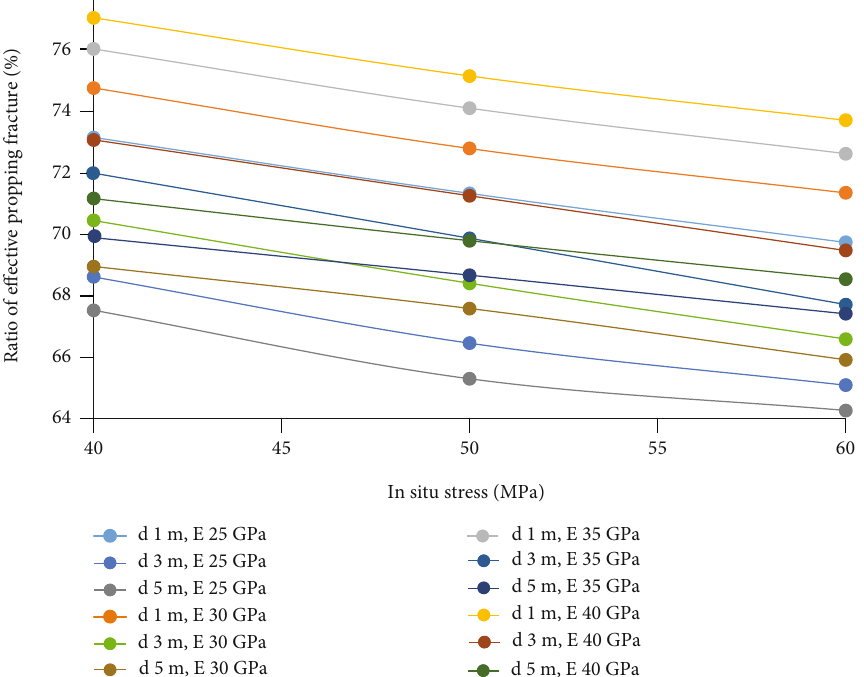
Figure 32: The proppant height is 5 mm, and the in fl uence of in situ stress under di ff erent diameters on the ratio of e ff ective supporting fractures.